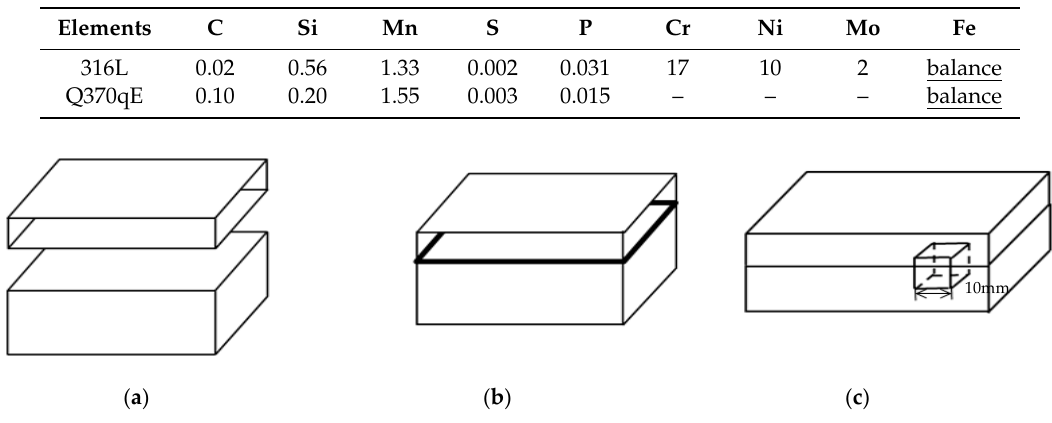
Table 1. Chemical composition of 316L / Q370qE steel (wt %).